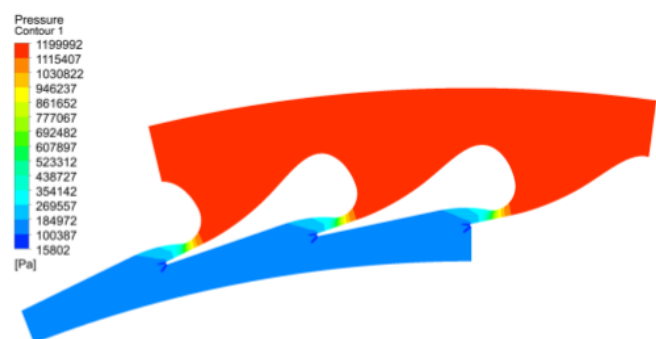
Figure 13: Static pressure distribution in the nozzle at 50% of the normalized span.